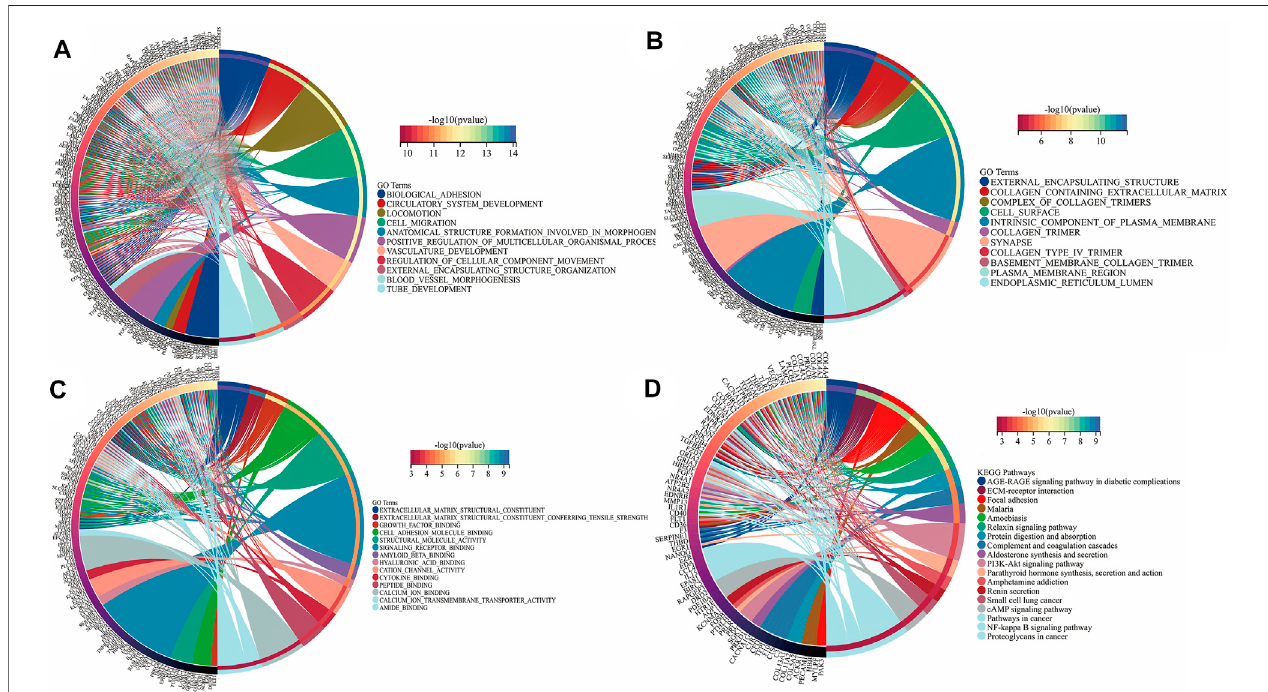
FIGURE 4 | Function annotation and KEGG analysis of DEGs in UF. (A) BP-terms; (B) CC-terms; (C) MF-terms; (D) KEGG pathways.